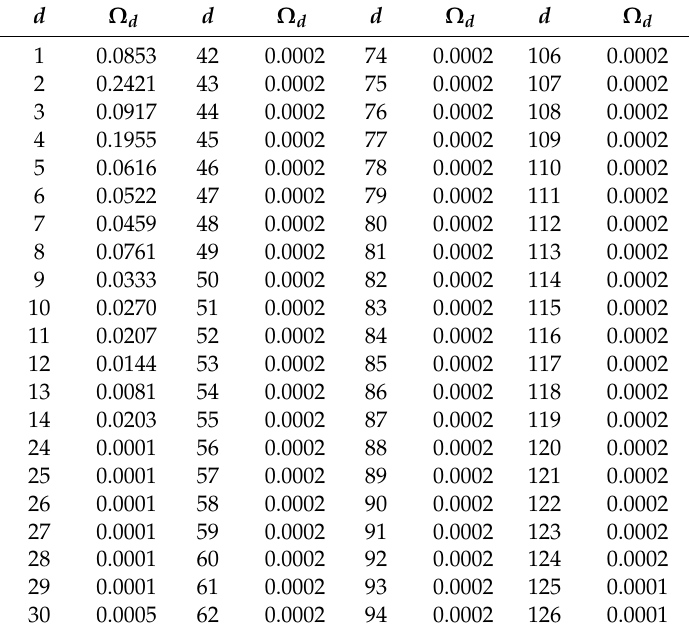
Table A2. Optimized Degree Distribution for MF-TWRN by the Proposed